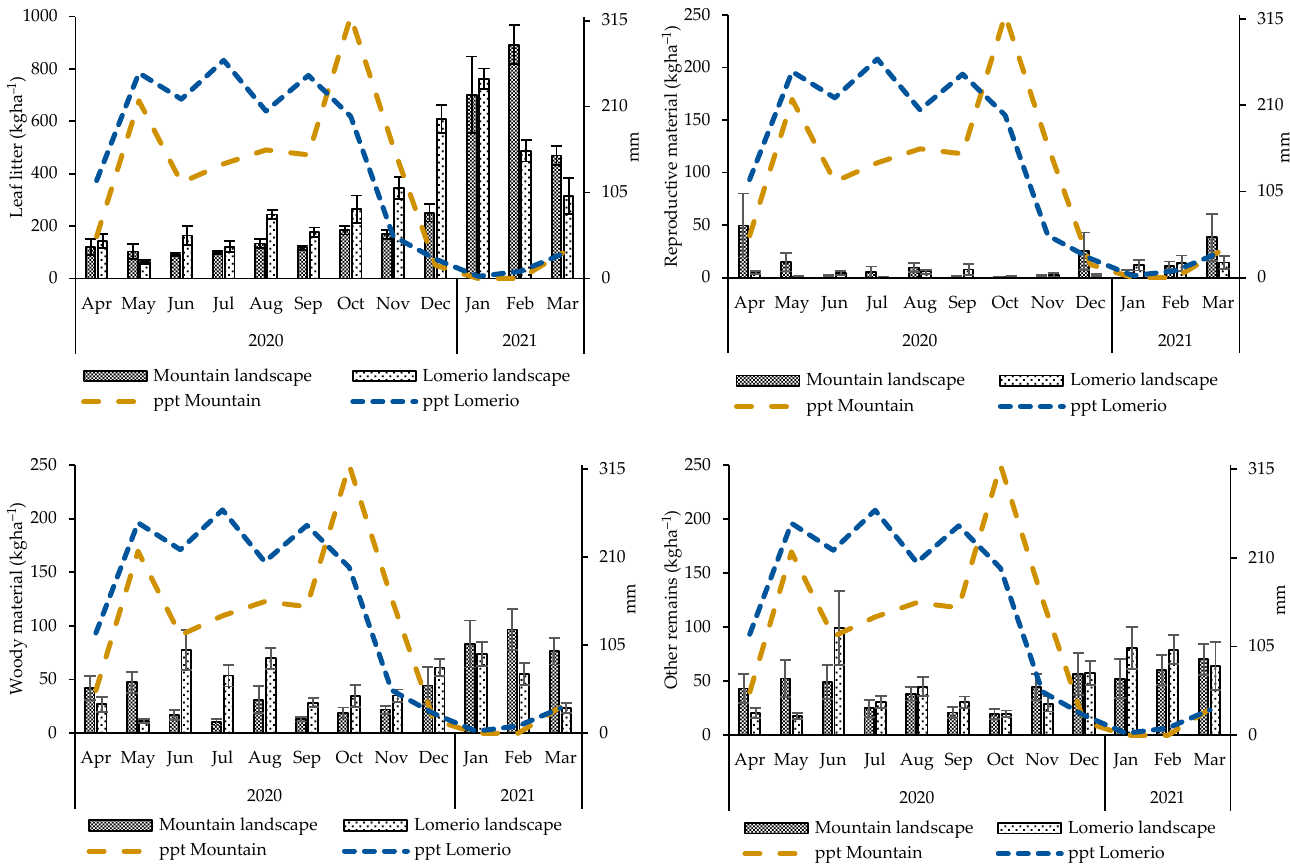
Figure 3. Monthly production of litter fractions (kg ha − 1 ) in landscapes of Magdalena, Colombia. ppt: precipitation. Mean ± SE ( n = 9 plots for Mountain landscape, and n = 12 plots for Lomerio landscape).